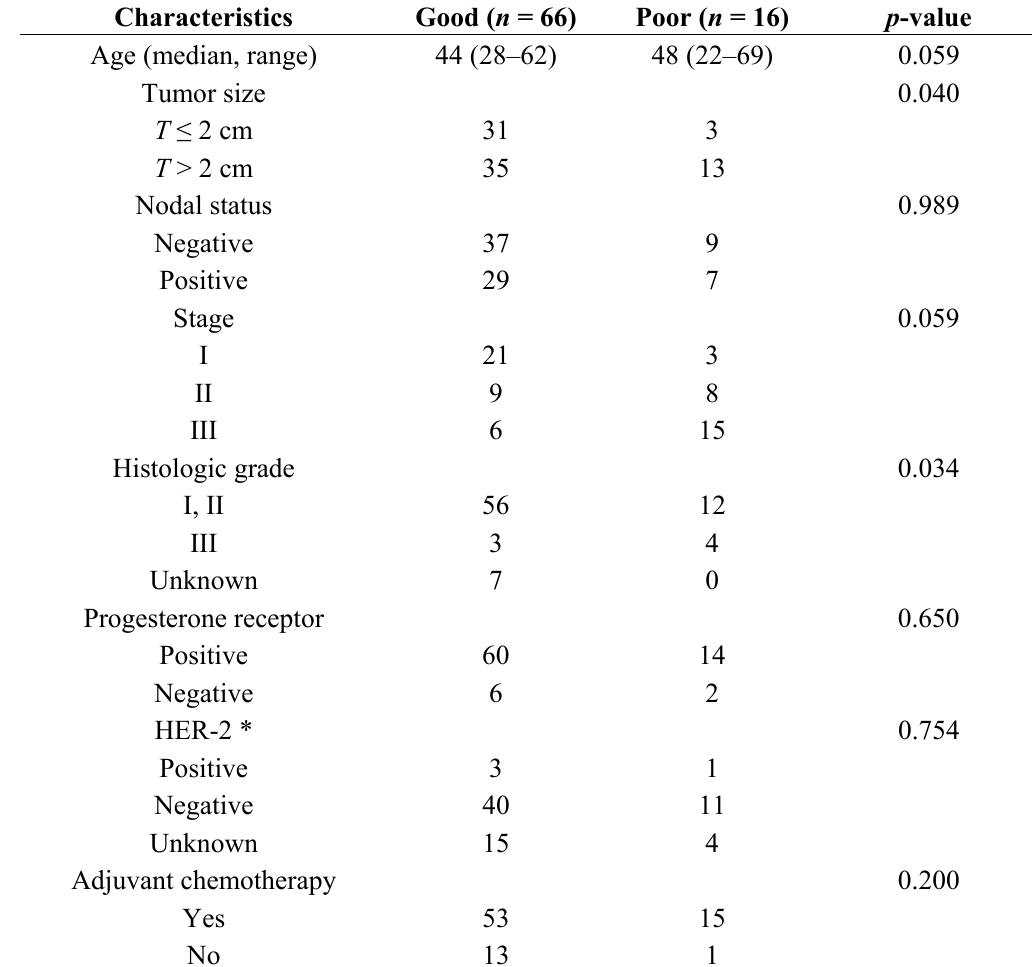
Table 2. Baseline characteristics according to 70-gene signature (70GS) predictor in ER-positive patients with intermediate RSs ( n =